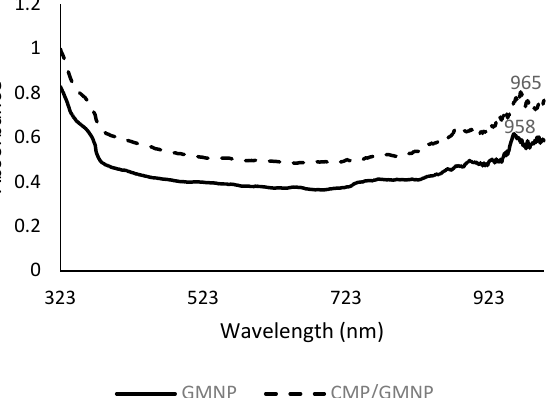
Figure 2. Comparative UV-Vis spectra that shows unmodified GMNPs and the surface-modified CMPs/GMNPs.